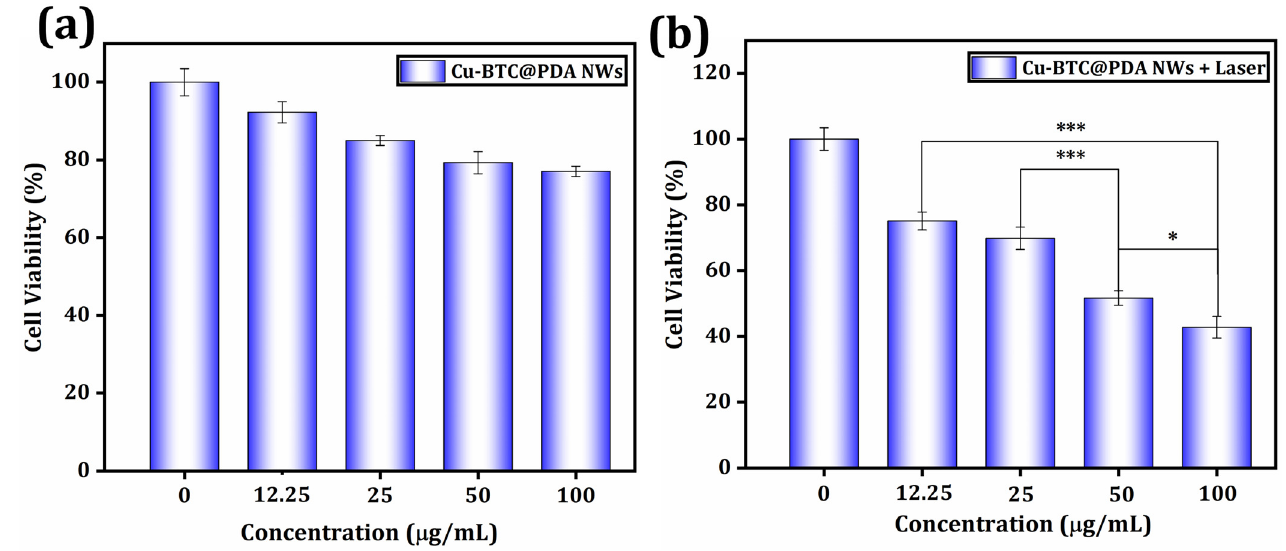
Figure 6. ( a ) Cytotoxicity and ( b ) photothermal therapy of HepG-2 cells with various concentrations of Cu-BTC@PDA NWs (808 nm/1 W/cm 2 ). * p < 0.01 and *** p < 0.0001.